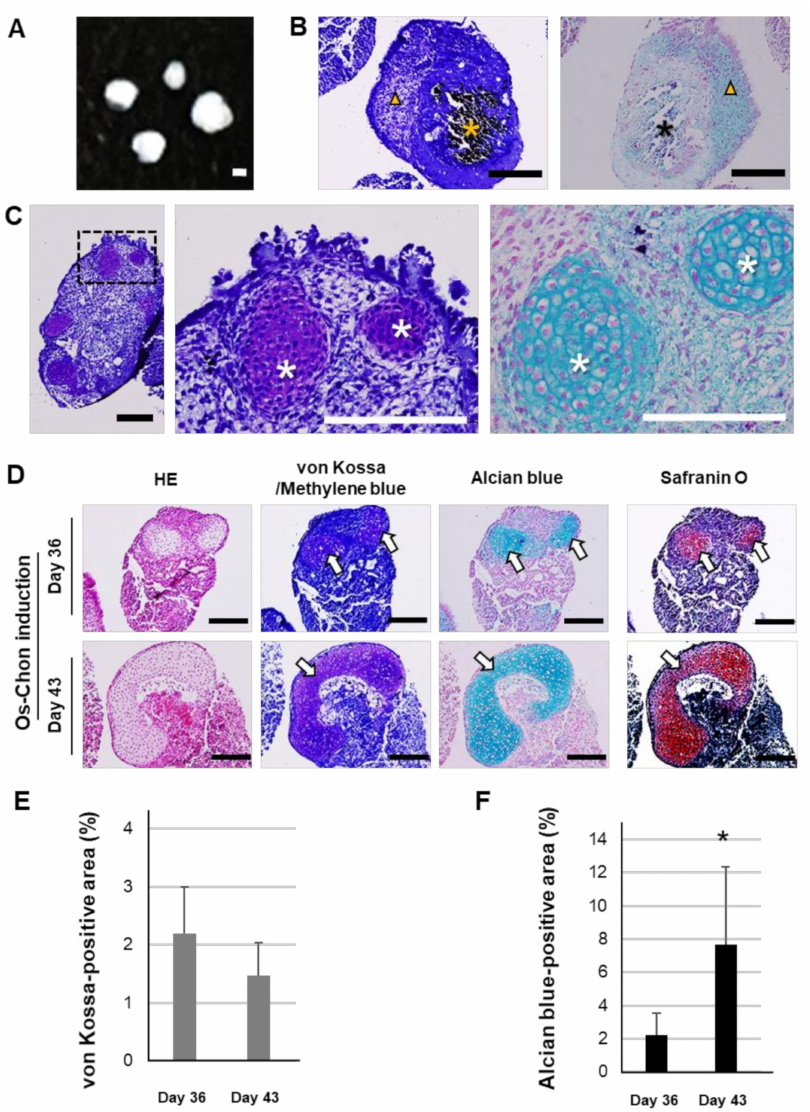
Figure 3. E ff ects of Os-Chon induction on mineralization and cartilage formation in osteo-chondrogenically induced iPSCs (OCI-iPSCs) constructs. ( A ) OCI-iPSC constructs on day 36. Scale bar; 200 µ m. ( B ) Histochemical staining with von Kossa and methylene blue (left panel)